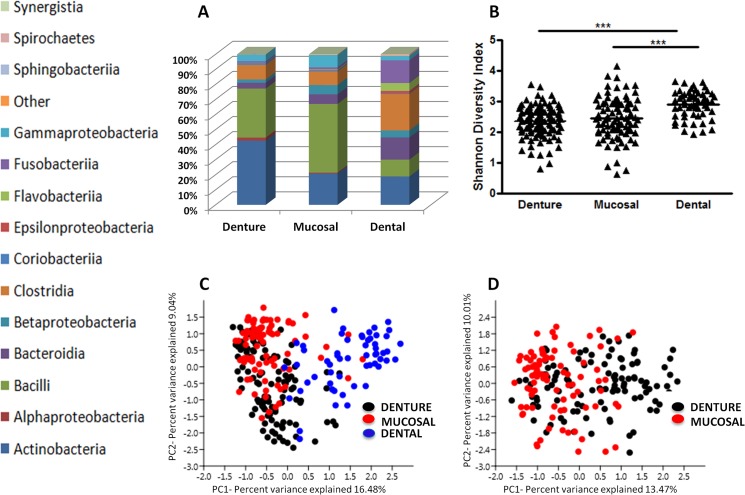
Microbial composition varies between sample sites in the oral cavity of denture wearers.One hundred and eight denture swabs, 87 mucosal swabs and 63 dental plaque samples underwent pyrosequencing of the 16S hypervariable V4 region to determine the bacterial composition of denture, palatal mucosal and dental plaque. A) Relative abundance of bacterial taxa at the class level per sample site. B) The taxonomic diversity of each group was analysed and compared via a Shannon Diversity Index. These diversity statistics show that both denture and mucosal plaque are significantly less diverse when compared to dental plaque. ***p<0.001. Principal component analysis (PCA) was applied to all sample types to reduce the multidimensionality of the data and to determine variances between C) Denture, Mucosal and Dental plaque. D) Denture and Mucosal plaque.